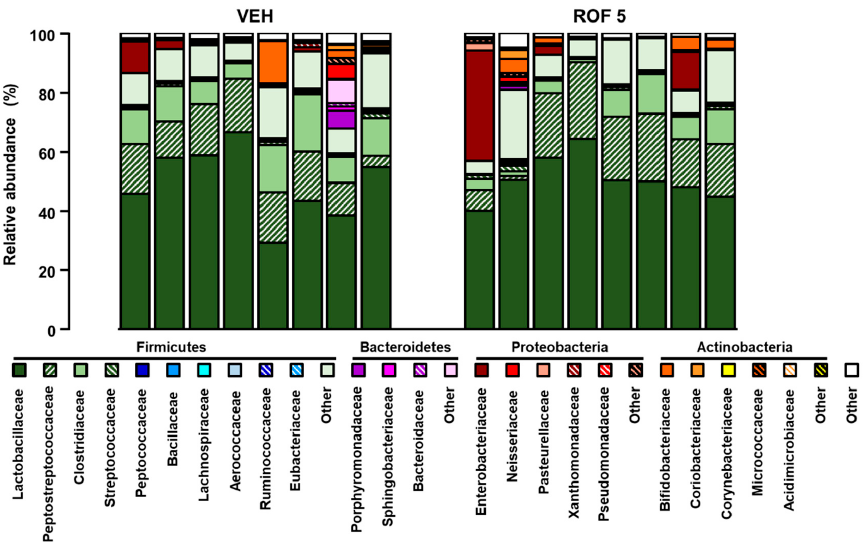
Figure 4. The relative abundance of bacterial families in jejunal samples of rats treated with vehicle (VEH, 1% methylcellulose) and rofecoxib (ROF, 5 mg/kg) for four weeks, determined by deep sequencing of 16S rRNA. Each vertical bar represents the sequencing data for one rat. Unclassified families and families with an abundance less than 0.1% are summarized as “Other”: Relative abundances of the bacterial families were compared between vehicle- and rofecoxib-treated groups by Wald test with Benjamini-Hochberg correction, which did not show any significant difference.